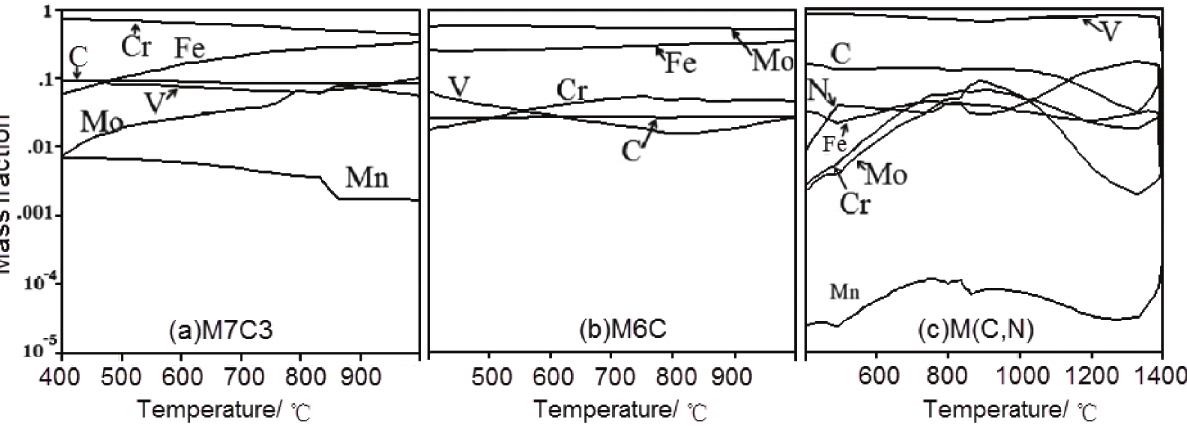
Fig. 4: Relationship between carbide compositions and